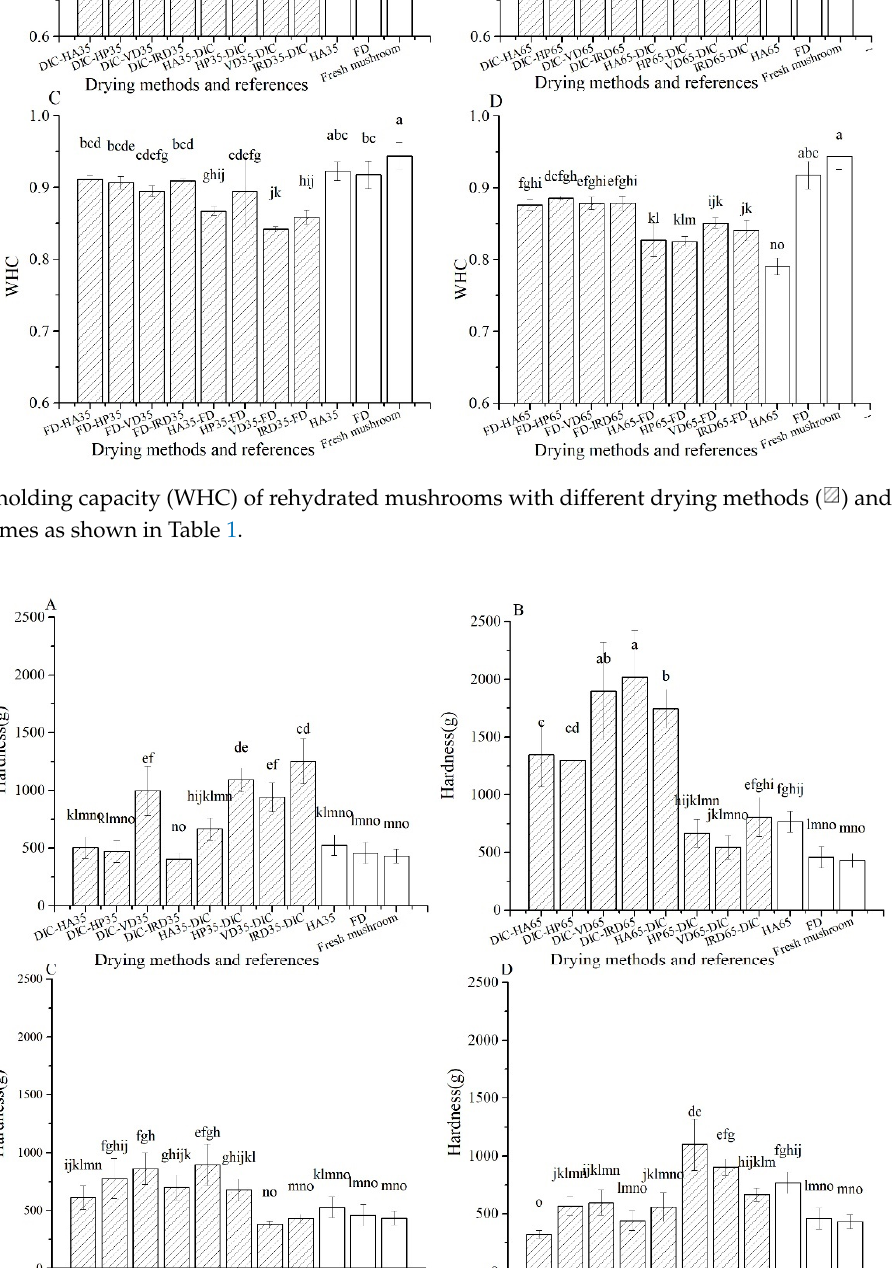
Figure 2. Volume recovery ratio of mushrooms after rehydration with different drying methods ( ) and references ( □ ). ( A–D ): group names as shown in Table1. ) and references ( (cid:3) ). ( A – D ): group names as